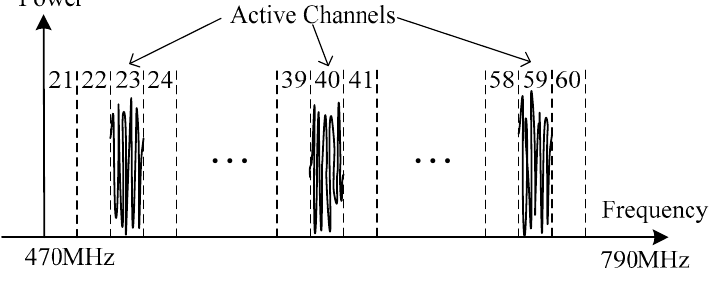
Figure 1. TV band with three users.